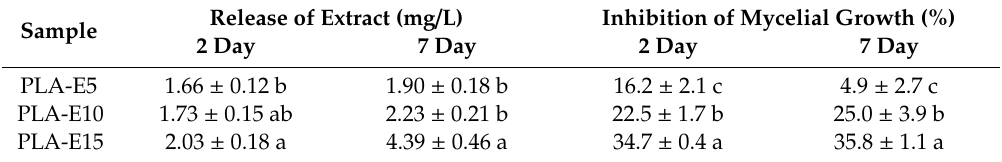
Table 4. Release of extract and inhibition of mycelial growth of B. cinerea onto PLA-E samples.